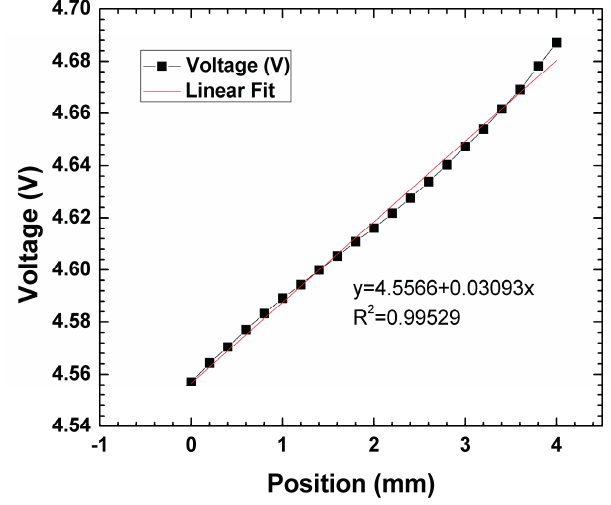
Figure 11. Coordinate plot over a 4-mm distance with 200 μ m.